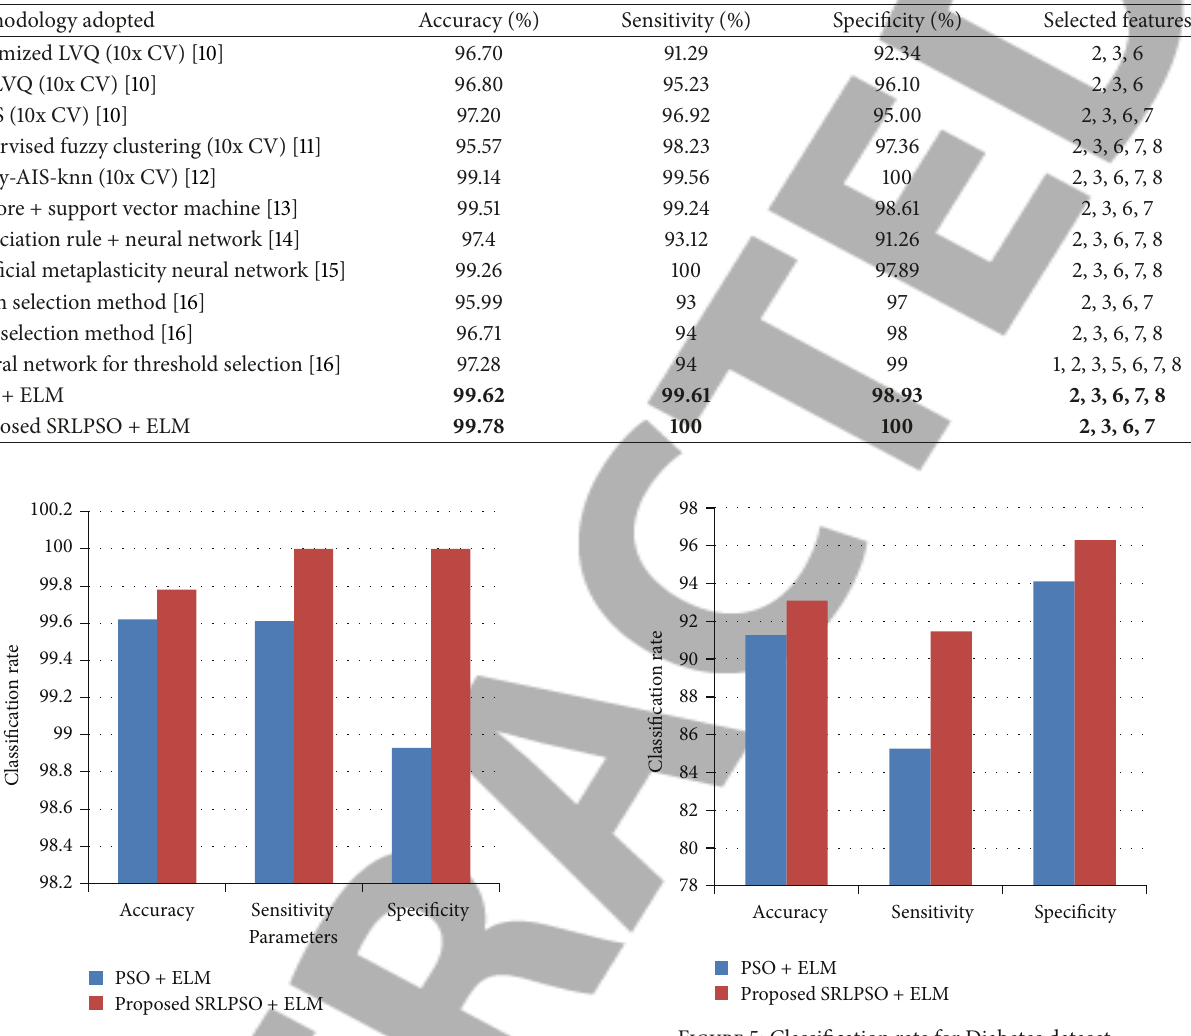
Figure 4: Classification rate for Breast Cancer dataset.